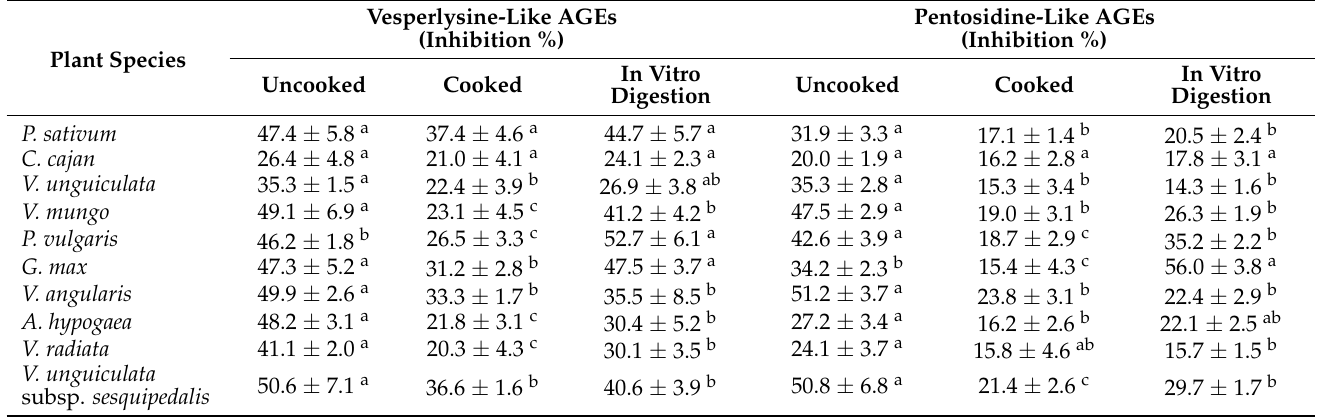
Different superscript letters indicate significant differences at p <